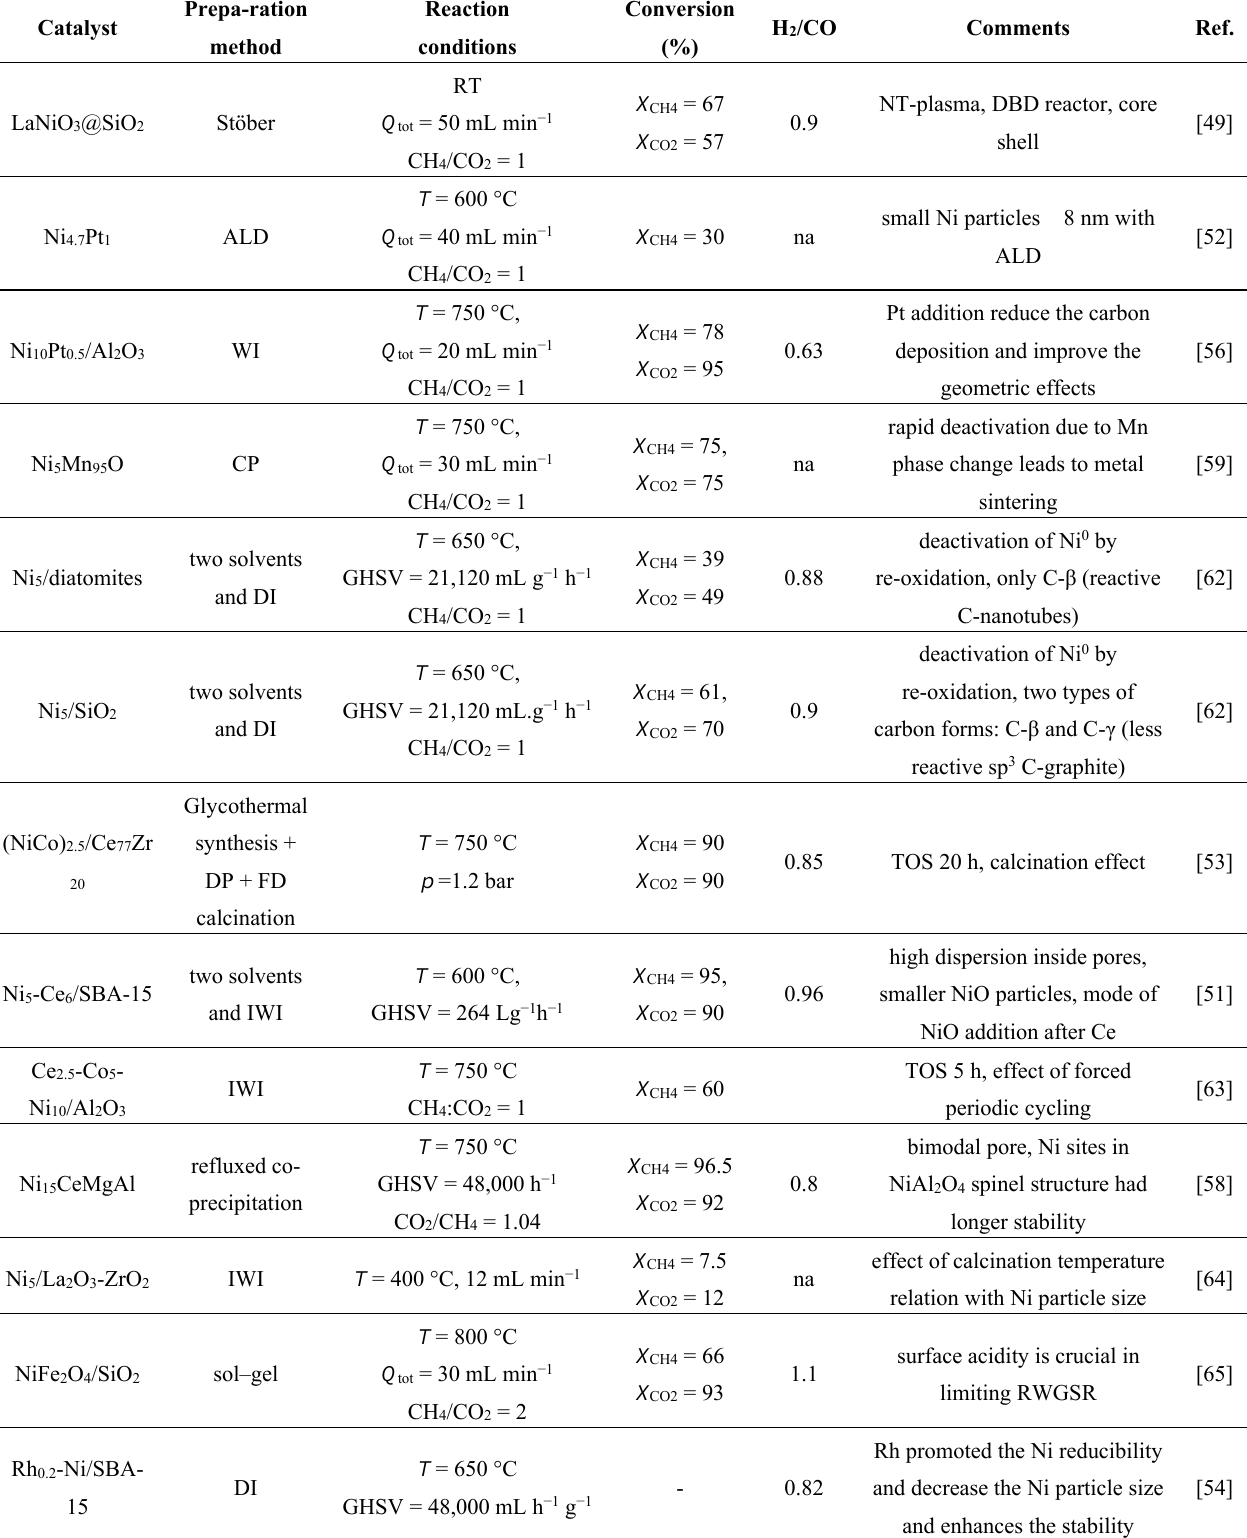
Table 2. Most recently studied Ni based catalysts in methane dry reforming (MDR) to syngas